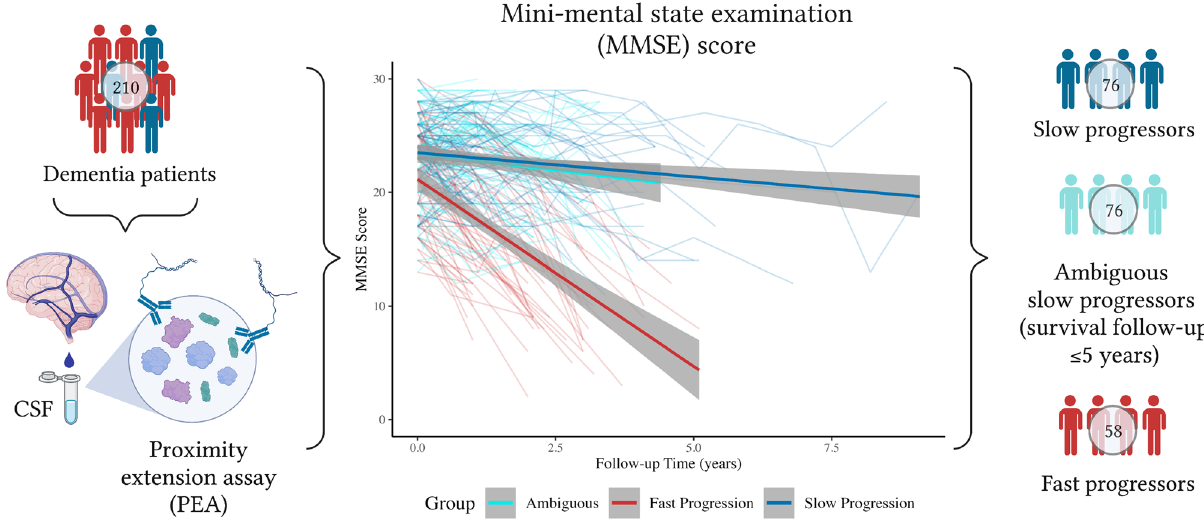
Figure 1. Patient demographics and identification of progressing groups. All CSF samples of patients were analysed by Olink proteomics and longitudinal MMSE measurements were collected. 210 patients with dementia and their MMSE scores over time were used to identify fast and slow decliners using latent class mixed models (LCMM). Shaded areas represent 95% confidence intervals. CSF cerebrospinal fluid, MMSE Mini- Mental State